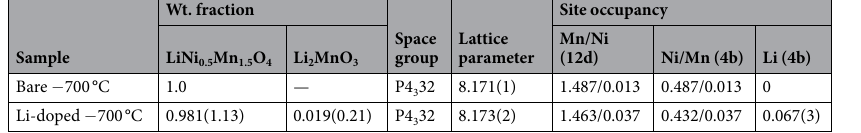
Fig. 1. In the Li-doped − 700 °C sample, the long-range ordering of the Ni/Mn is similar to the ordered structure heat-treatment at 700 °C for 48 h which typically results in a Ni/Mn ordered spinel. Both samples were additionally characterized by Raman spectroscopy as shown in Fig. 3. Raman spectroscopy strong signal of A1g band at 633 cm − 1 and the split of the F 2g(1) band at 593 and 612 cm − 1 are ascribed to the sym-